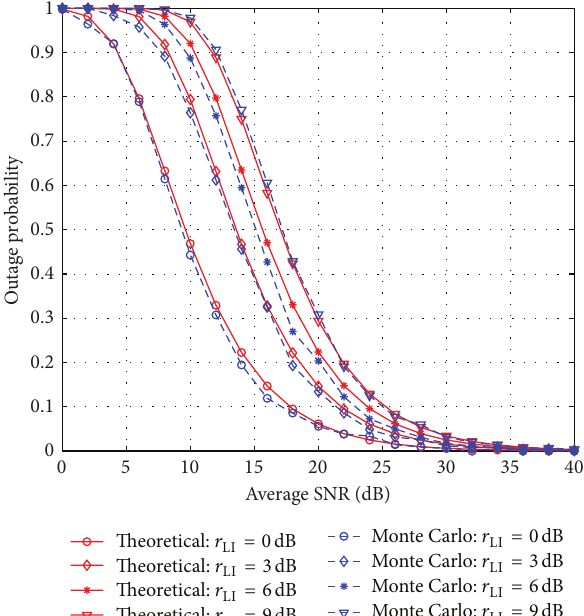
= 5 dB and average SNR 𝑟 th